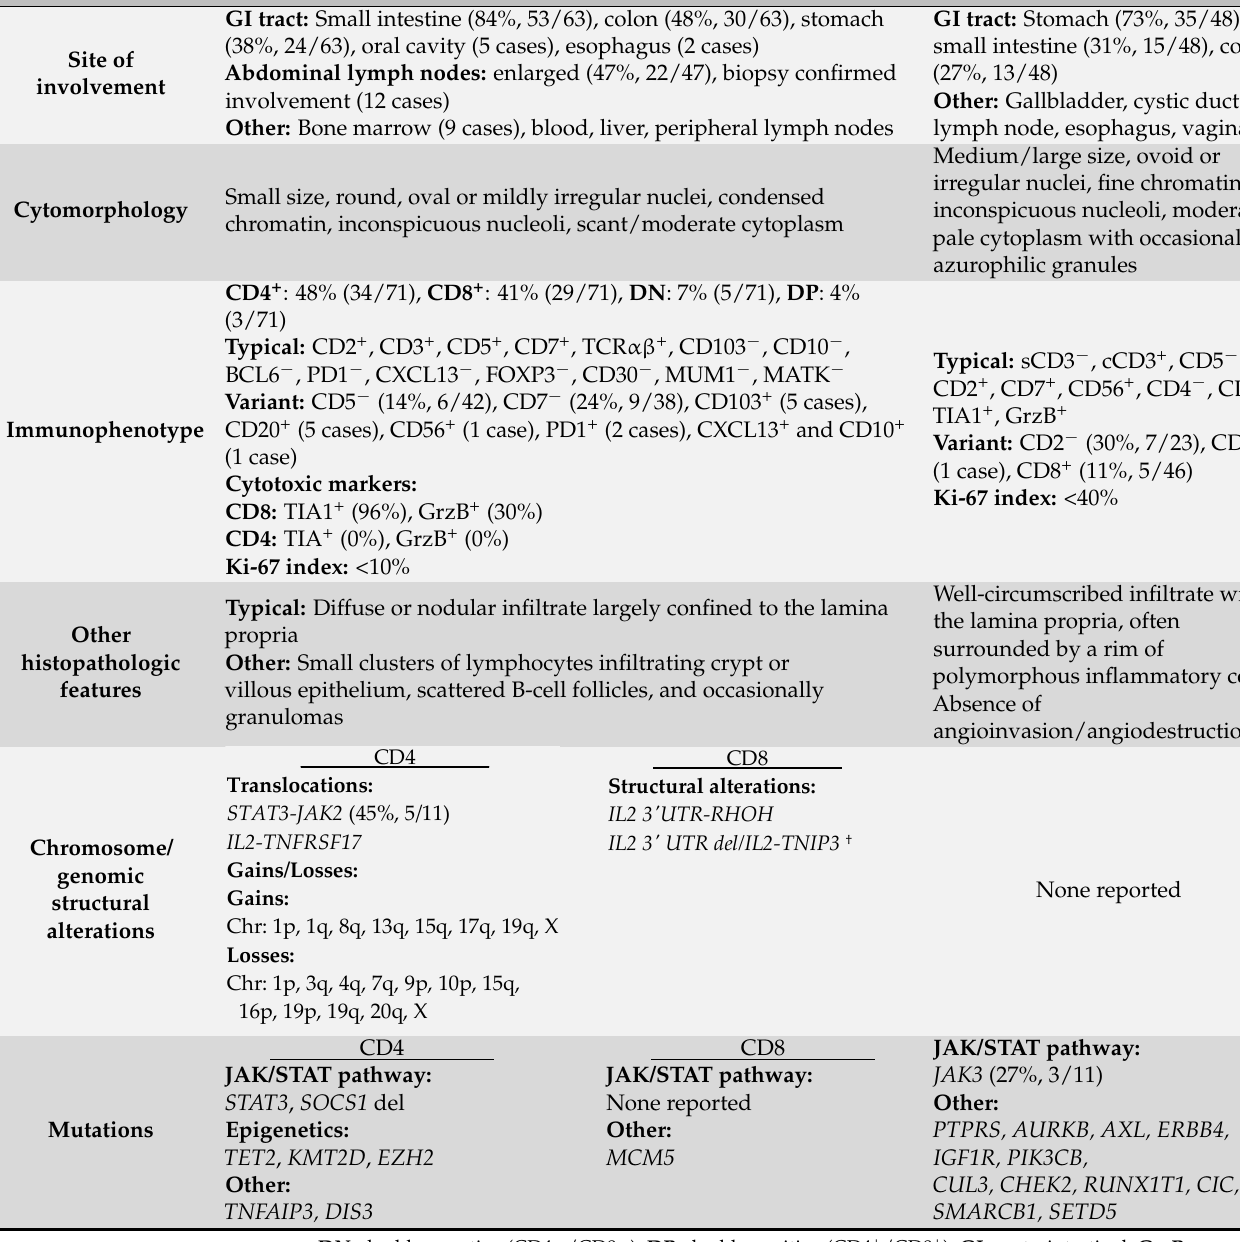
Table 1. Pathologic and genetic characteristics of ITLPD-GI and NKCE.